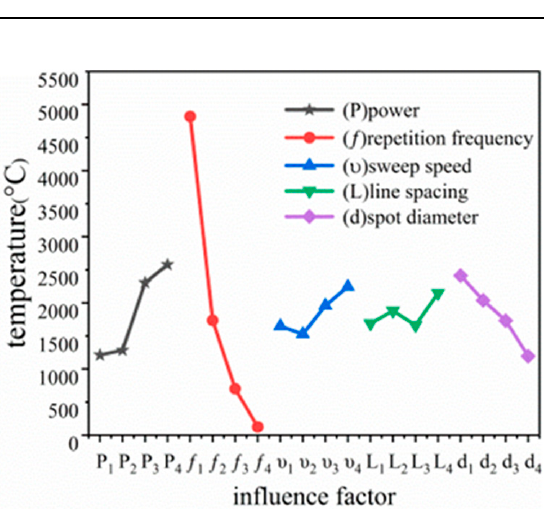
Figure 7. The trend of the influence of the temperature field of each factor.